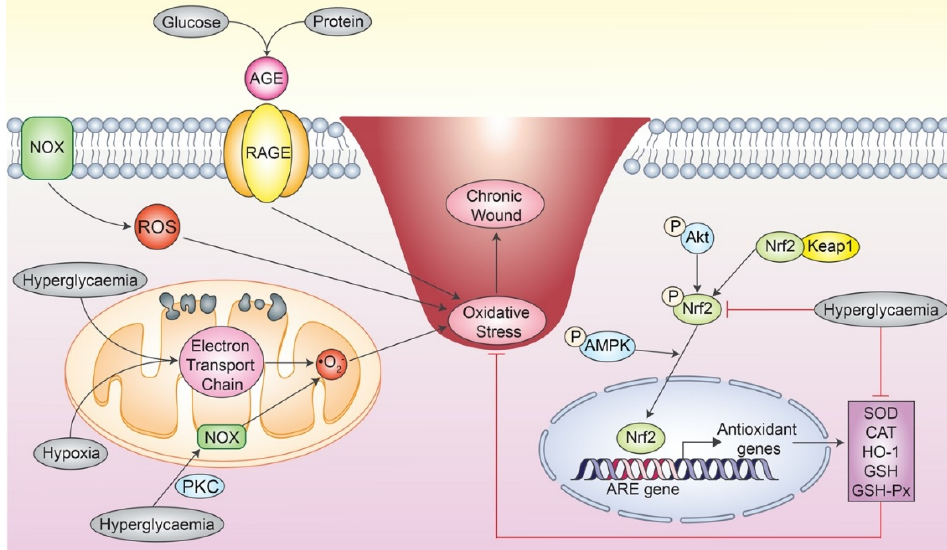
Figure 2. Oxidative stress underlying a chronic wound. Excessive ROS are produced via the mito- chondrial electron transport chain under hyperglycaemia and hypoxic condition. Hyperglycaemia can also activate mitochondrial NOX activity via PKC. Next, the formation of AGE from the reaction between glucose and protein binds to its receptor, RAGE, which induces signalling that leads to oxidative stress. Besides promoting the formation of oxidants, hyperglycaemia also inhibits the Nrf2 signalling, which leads to downregulated expression of antioxidants. Altogether, the persistent re- dox imbalance leads to severe oxidative stress and results in a chronic wound. AMPK: adenosine monophosphate-activated protein kinase; AGE: advanced glycation end product; ARE: antioxidant response